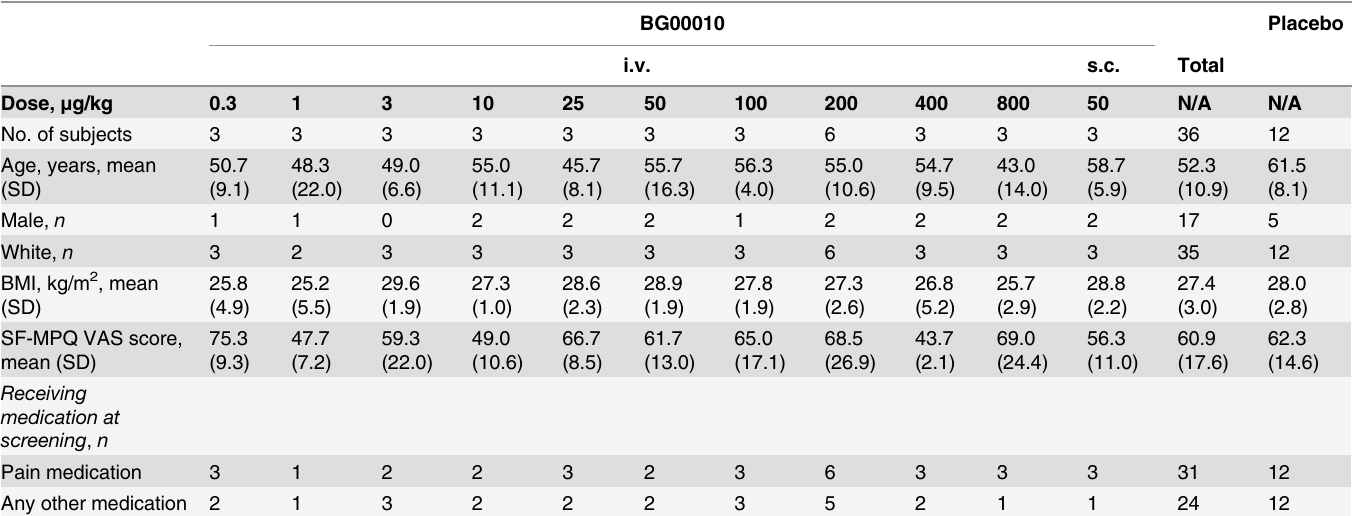
Table 1. Baseline demographics and clinical characteristics.